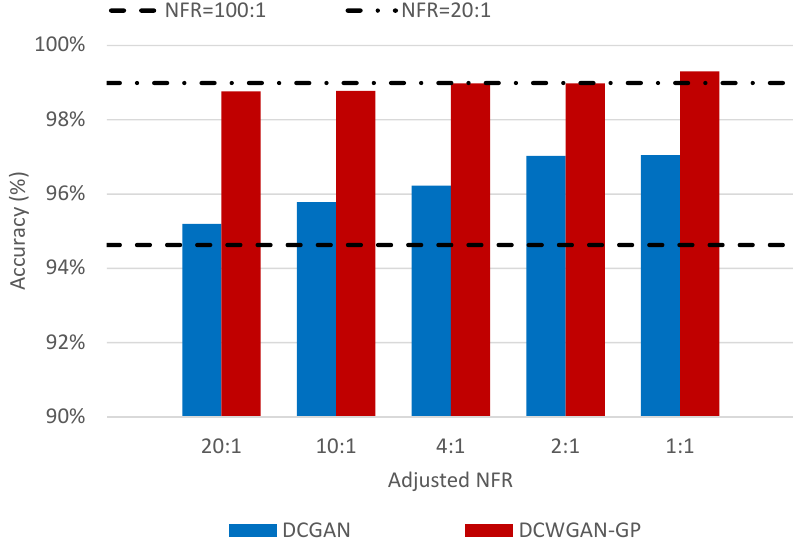
Figure 15. FDD accuracy testing:NFR = 100:1 with 10,000 normal